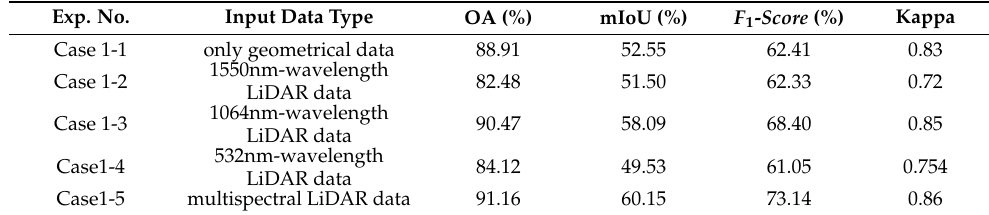
Table 5. Point cloud classification results with the different input data under three test areas (11–13). Exp.